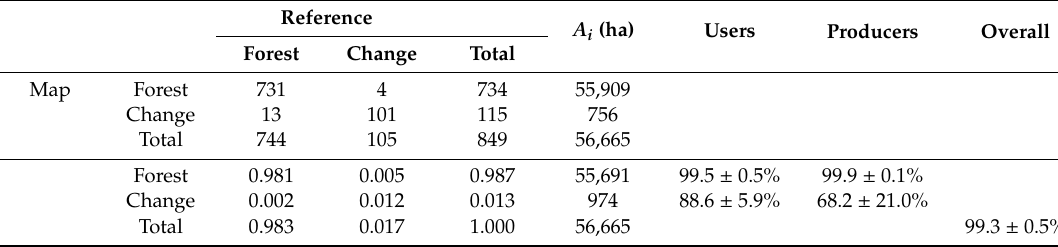
Table 5. Error matrix for Malawi, plausibility approach—2